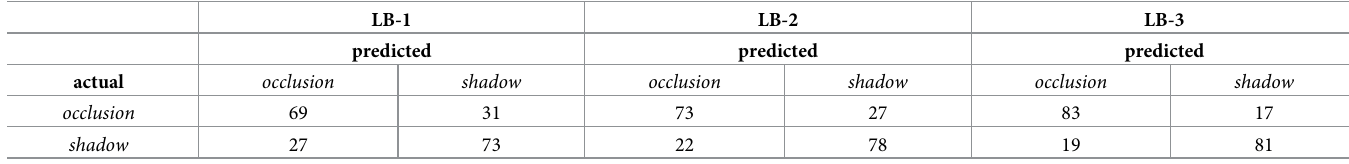
Table 2. AO confusion matrix for all LB